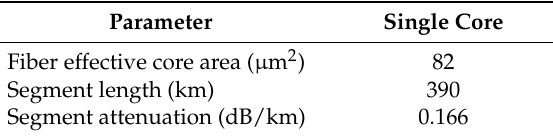
Table 3. Conventional single fiber core